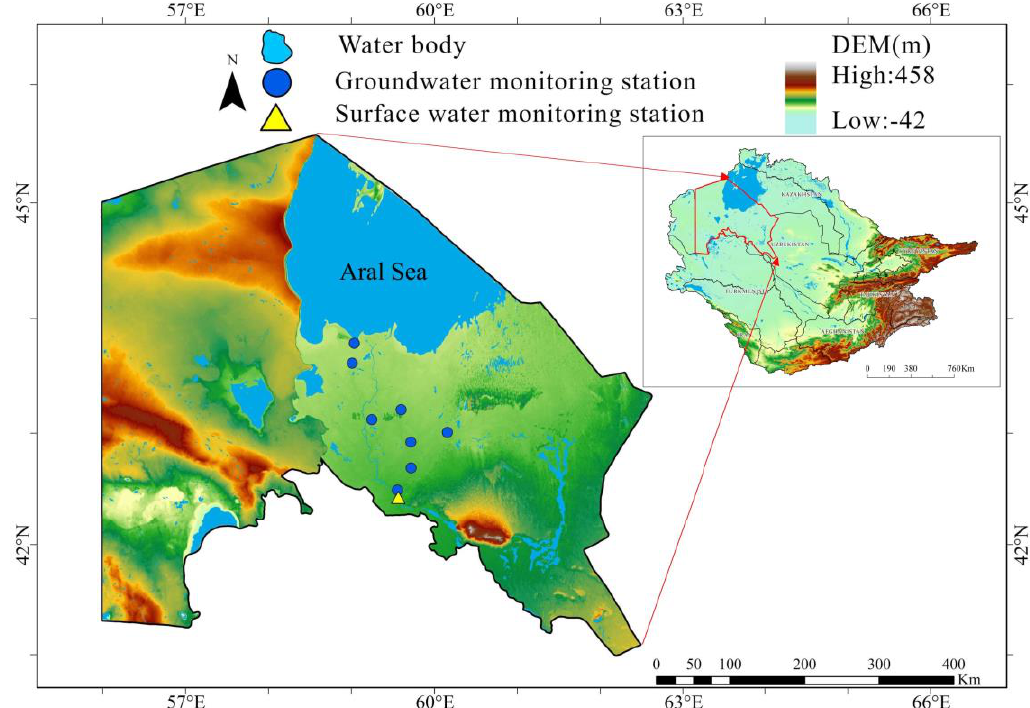
Figure 1. The geographic location of the Amu Darya Delta, groundwater monitoring stations (blue dots), and surface water monitoring stations (orange triangles). The Digital Elevation Model is from the Shuttle Radar Topography Mission (http://srtm.csi.cgiar.org/).